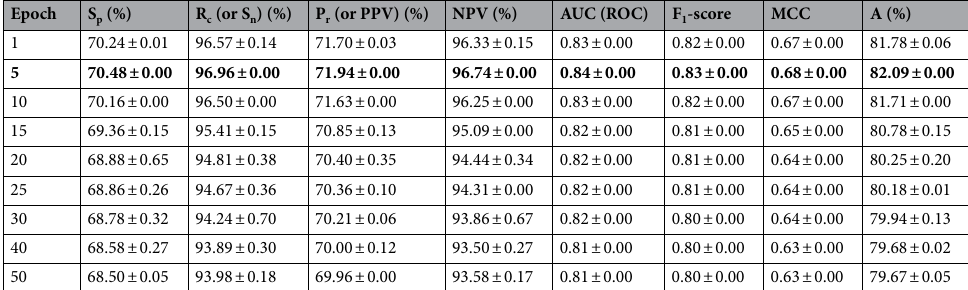
Table 5. Proposed system results (tenfold-cross validated) with epochs variation depicting analysis-based performance using k -NN classifier with k = 1 for BraTS-2021 dataset (without RA). Significant values are given in bold.